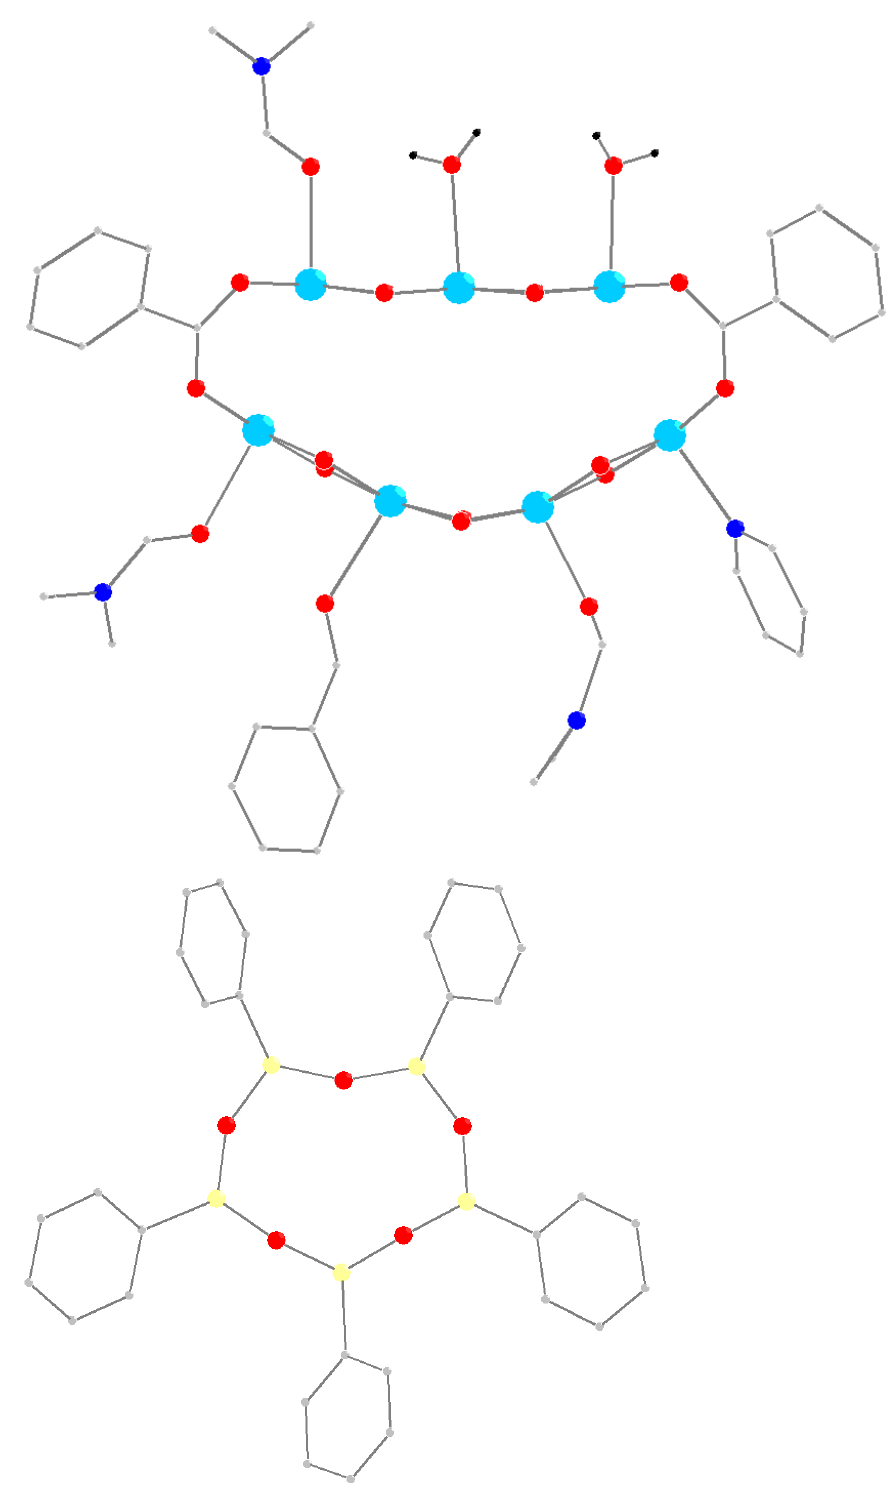
Figure 2. ( Top ) Representation of copper ions location and their multi-ligation style in 1 . ( Bottom ) Distorted pentameric siloxane ligand in 1 . The color code is the same as in Figure 1.